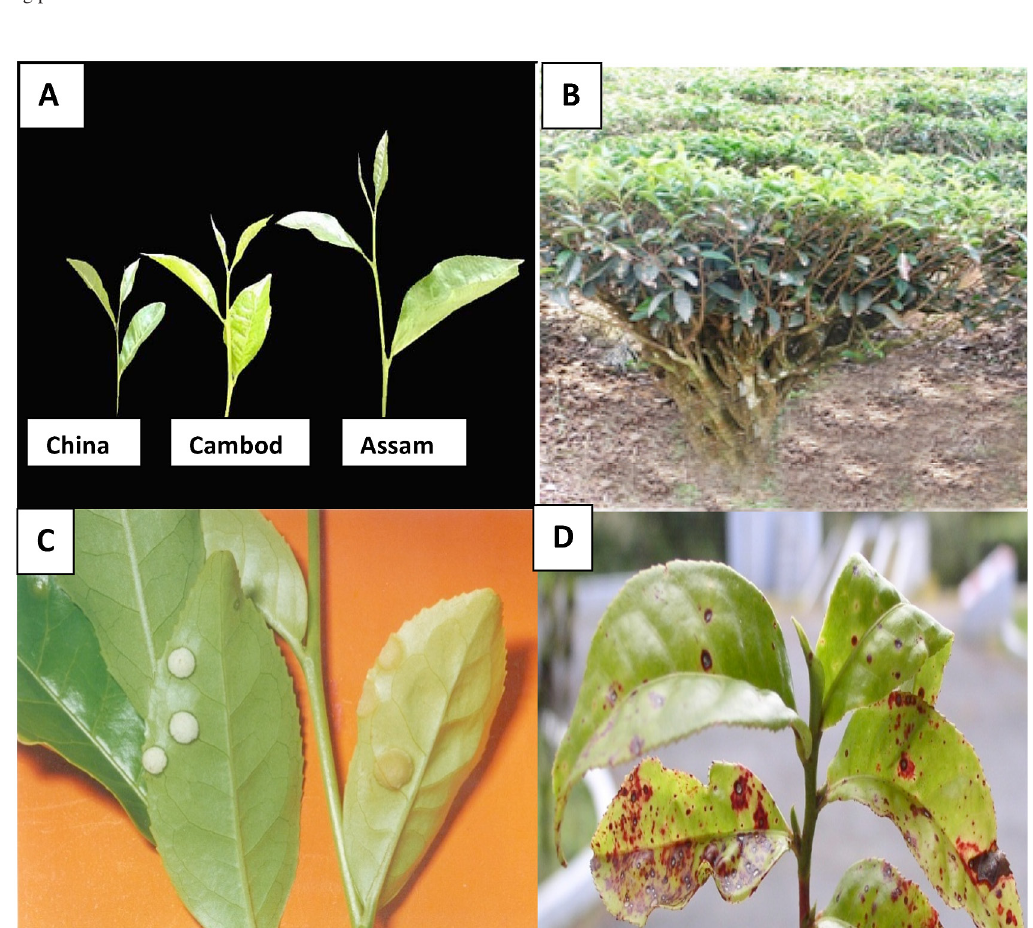
Fig. 3: Architectural characters of tea plants and blister blight infection. A, Different tea cultivar harvestable shoots; B, A typical tea bush; C, Sporulating lesions of blister blight infected tea shoots and; D, Necrotized lesions of blister blight infected tea